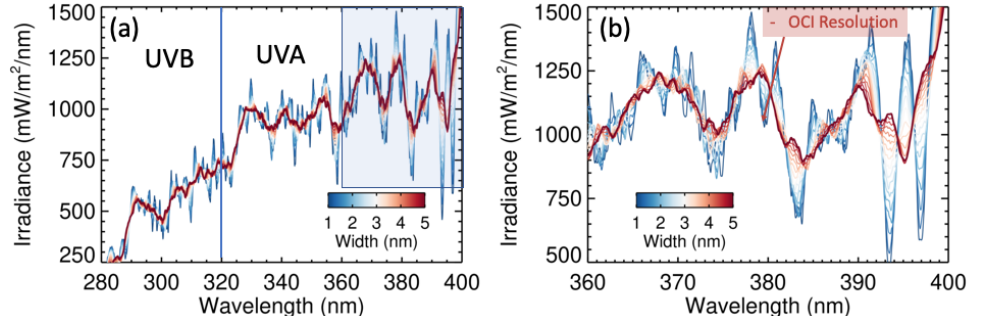
Figure 1. Extraterrestrial spectral irradiance at different spectral resolutions shown for ( a ) the entire UV spectral range and ( b ) the OCI spectral range shown in the light blue cutout in ( a ). The color bar represents the boxcar smoothing width in